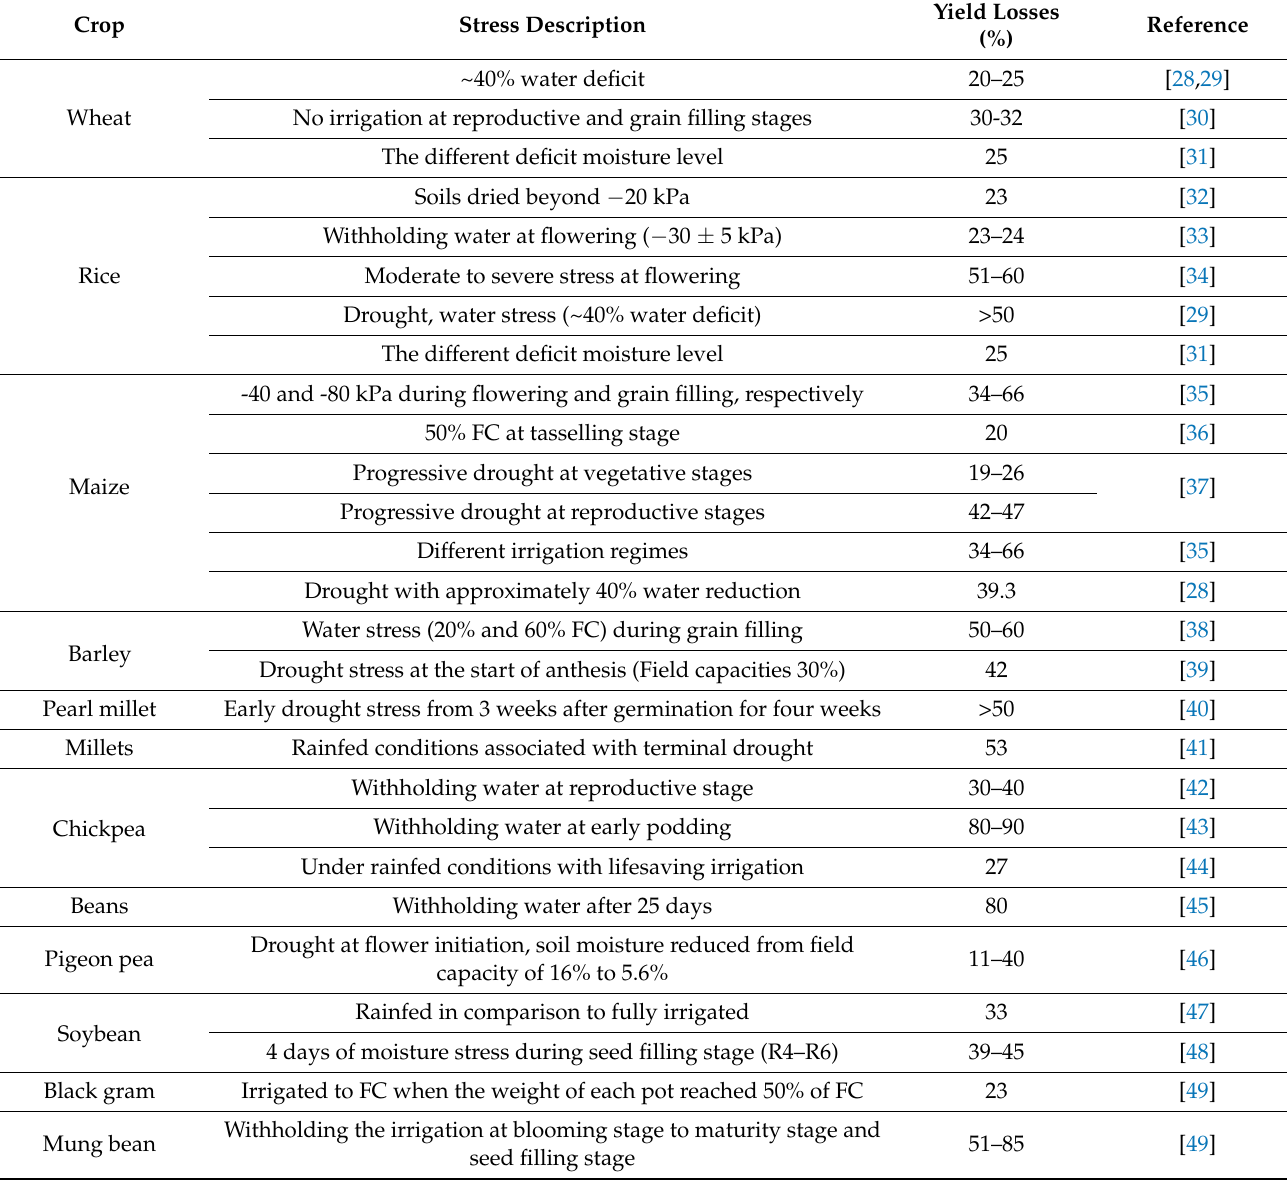
Table 1. Effects of drought stress on yield of different cereal and legume